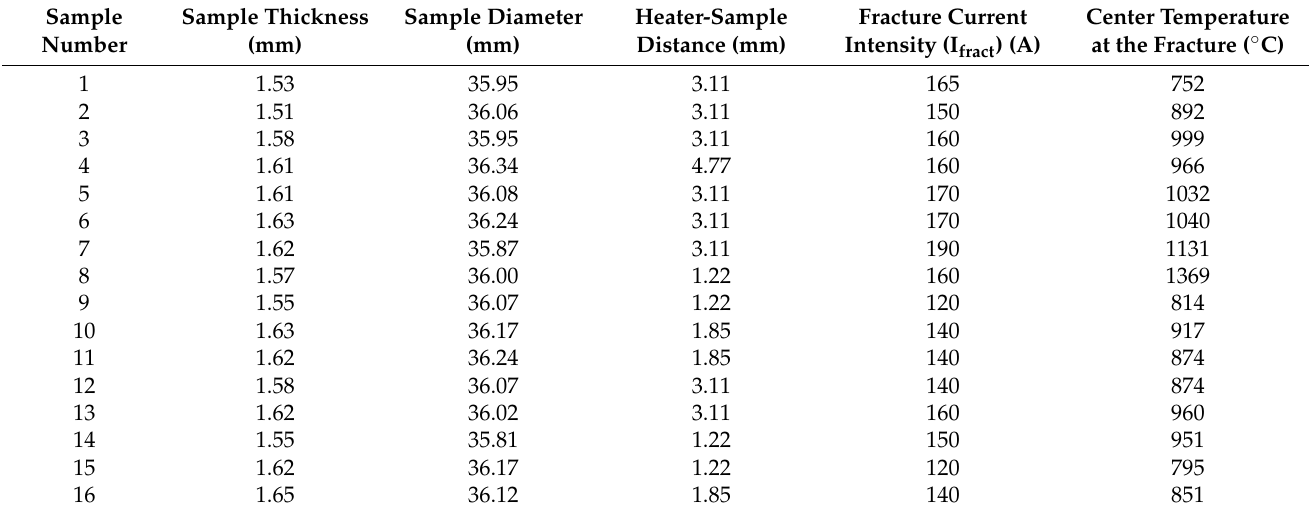
Table 4. Data recorded for the 16 samples for which a complete failure was